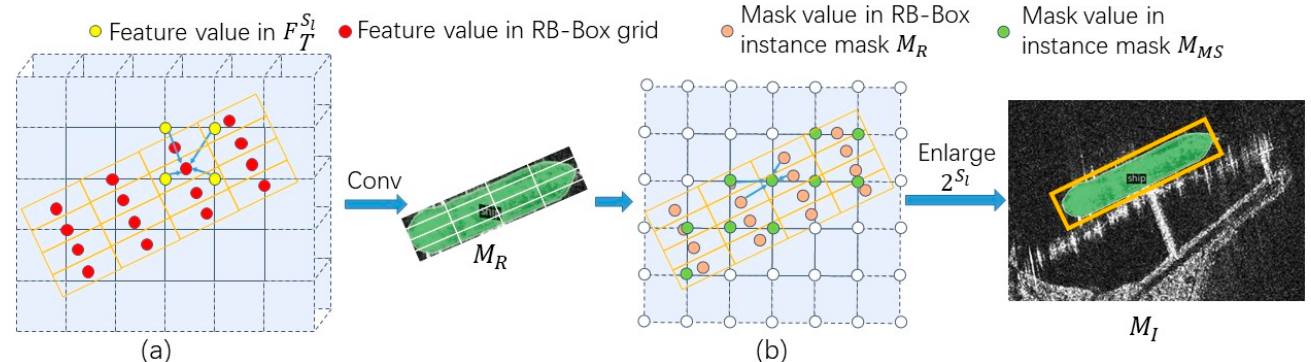
Figure 7. The pipeline of the RB-Box instance mask prediction: ( a ) indicates the feature sampling process, and ( b ) indicates the mask sampling process. In ( a ), the feature values in the RB-Box are computed with their nearest feature values in F S l . Then a standard 1 × 1 convolution, Conv, is used T to produce the instance mask, M R , in the RB-Box. In ( b ), the instance mask values in instance mask M MS are computed with their nearest mask values in the RB-Box instance mask, M R . Then, the M MS is enlarged 2 S l times to obtain the instance mask M I in the original SAR